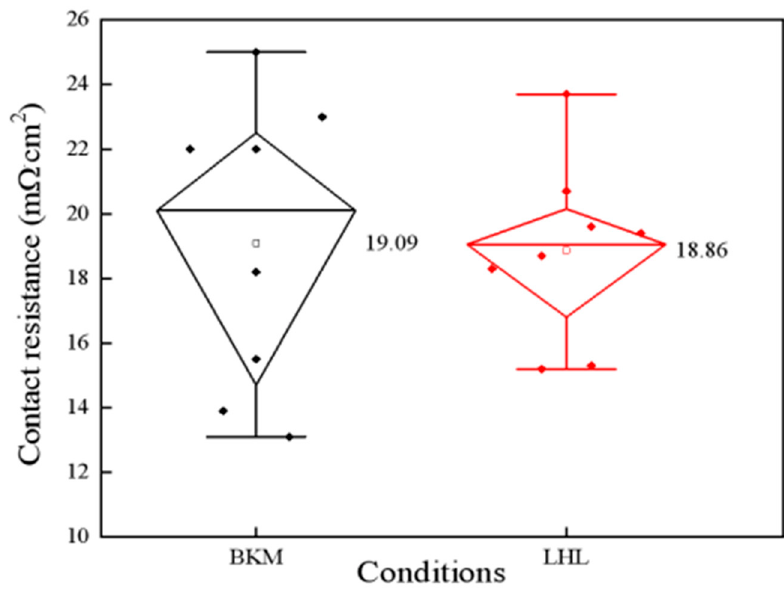
Figure 6. Contact resistivity of solar cells from LHL and BKM diffusion processes.